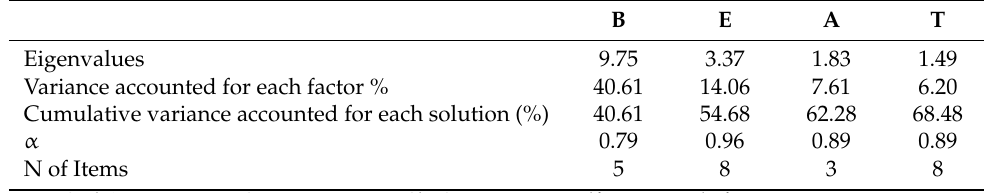
Table 1. Eigenvalues, variance, and Cronbach’s α .